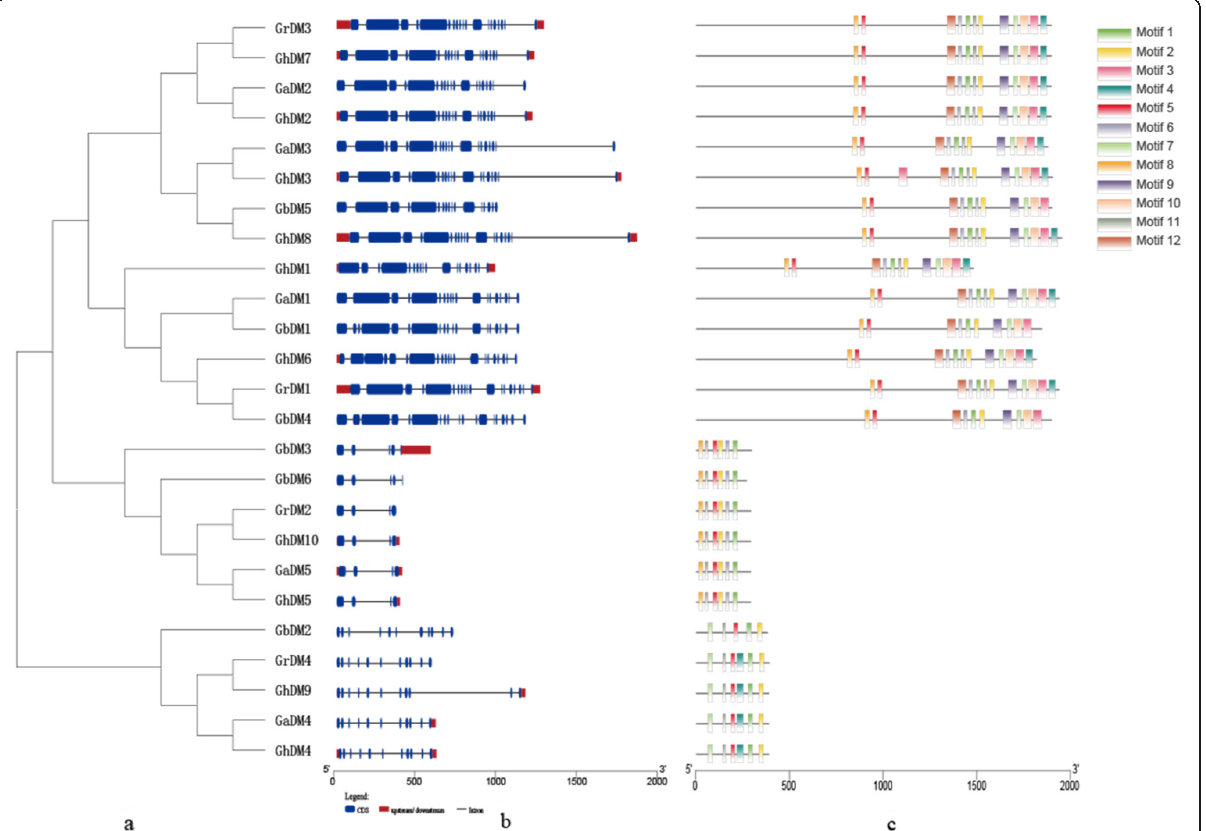
Fig. 1 Evolutionary relationship, gene structure, and protein domain analysis of cotton DNA demethylase gene family. a family phylogenetic tree analysis; b gene structure; c protein